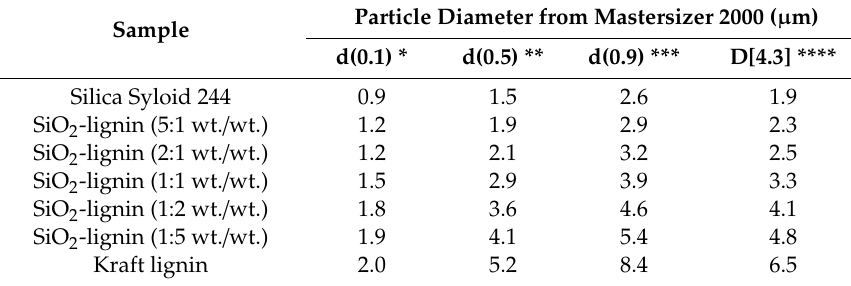
Table 1. Particle diameter of silica, kraft lignin and silica-lignin hybrids. Particle Diameter from Mastersizer 2000 ( µ Sample